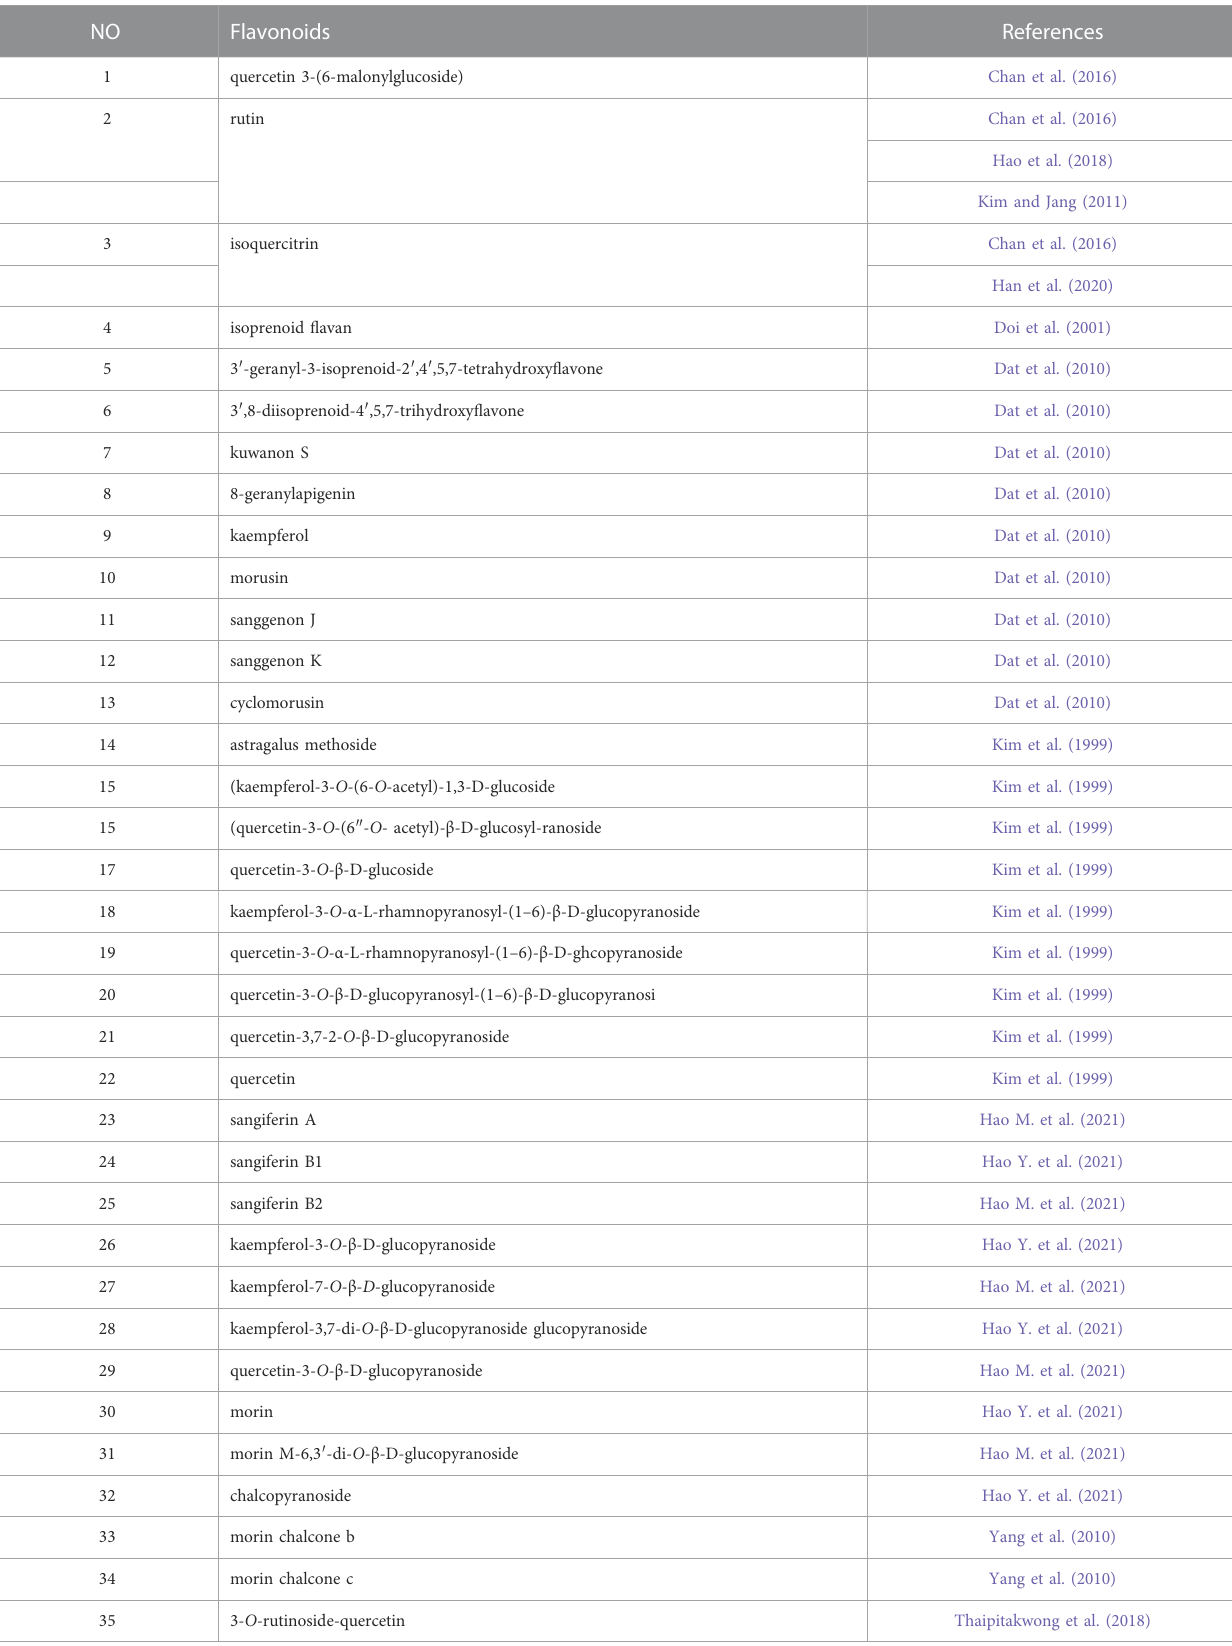
TABLE 1 Main chemical composition of mulberry